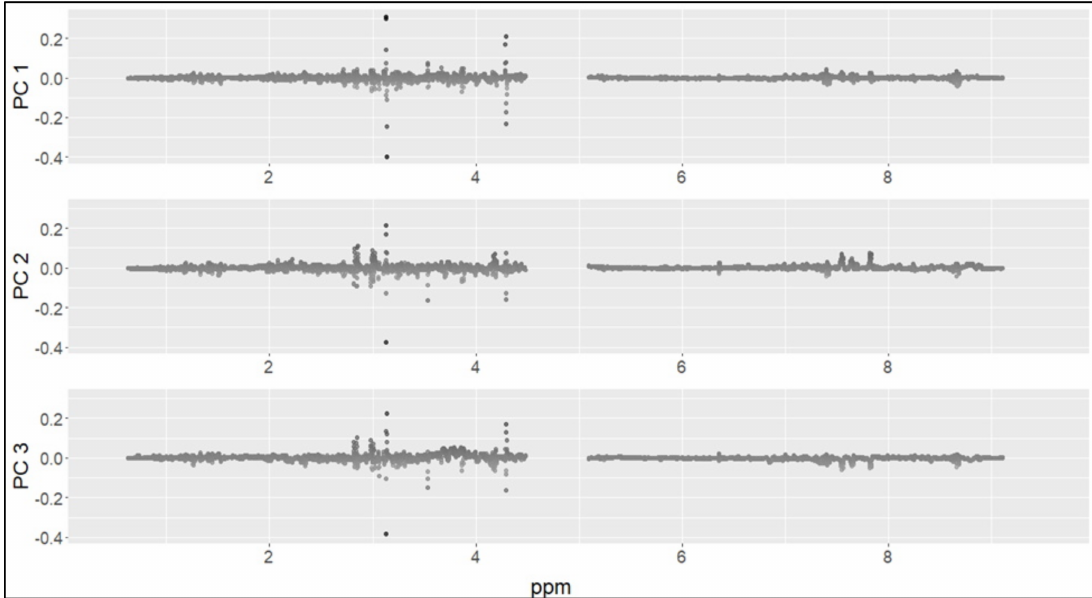
Figure 4. Values of the loadings of the first three principal components; the graphs illustrate which metabolite spectra (ppm) were most responsible for the “variance” in each of the three main components (i.e., the metabolite that has the higher absolute